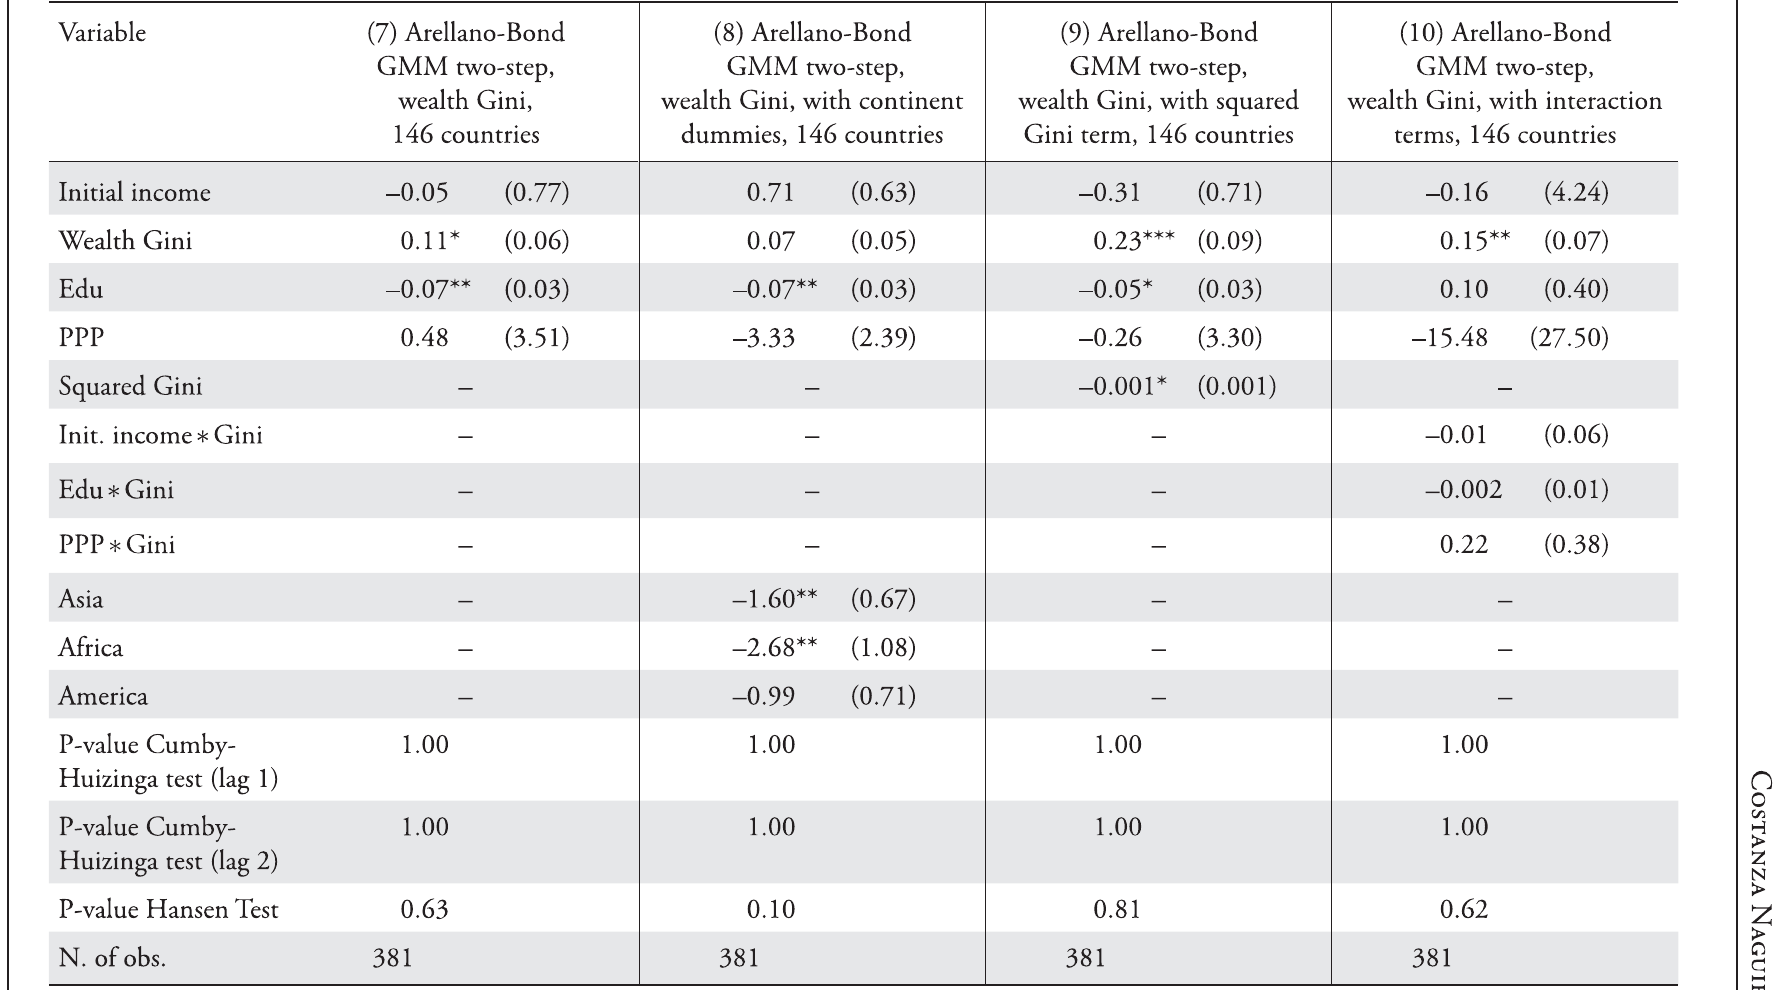
Table 6: Impact of wealth Gini on real GDP per capita growth- Arellano-Bond GMM estimates (7) Arellano-Bond (8) Arellano-Bond (9) Arellano-Bond (10)Arellano-Bond wealth Gini, with continent wealth Gini, with squared wealth Gini, with